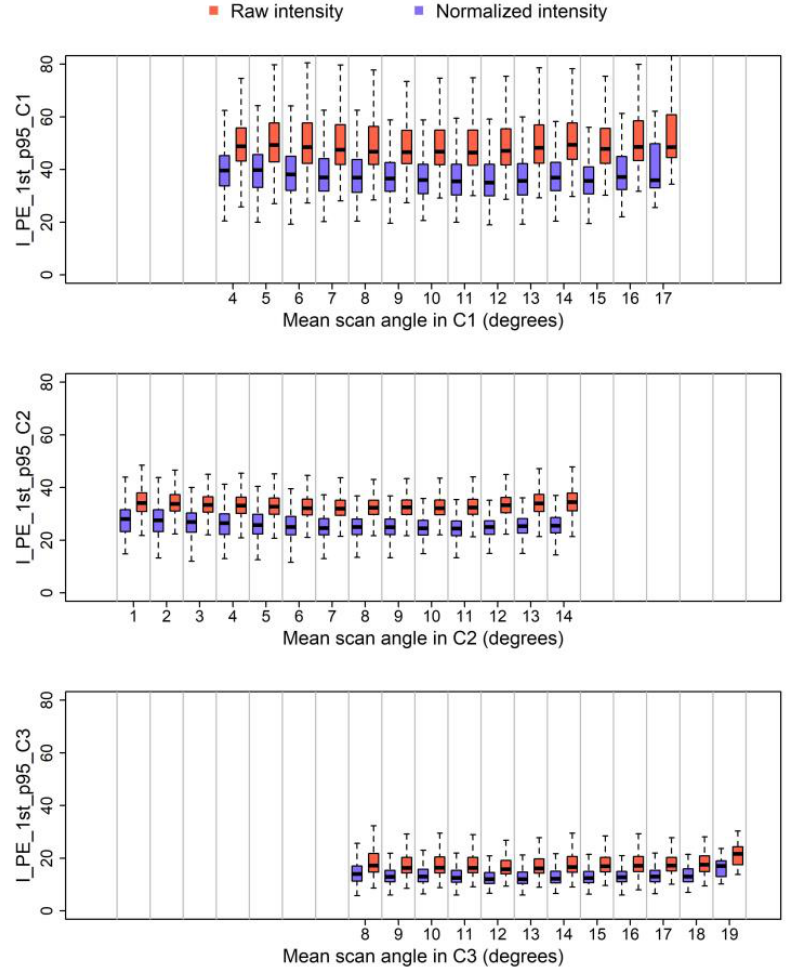
Figure 7. Raw and normalized values for the 95th percentile of intensity in the three channels as a function of mean scan angle.